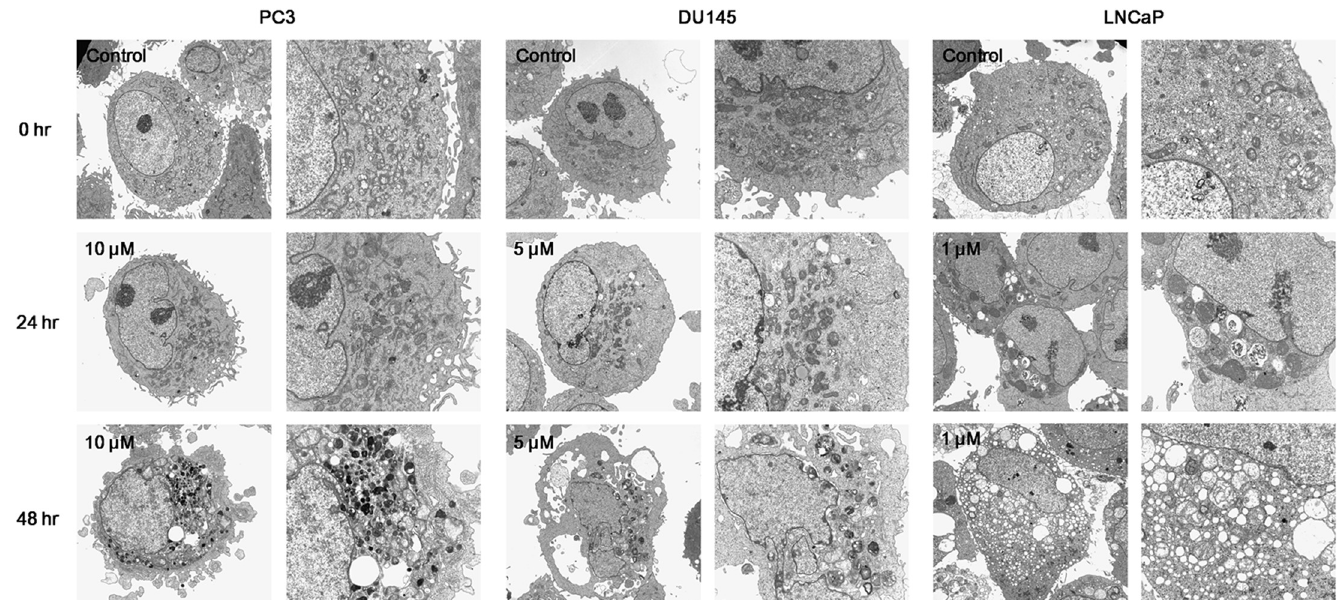
Fig 2. Structural features observed by electron microscope (10000× and 5000×) in PC3, DU145, and LNCaP prostate cancer cells treated with KML001 for 24 and 48 h.